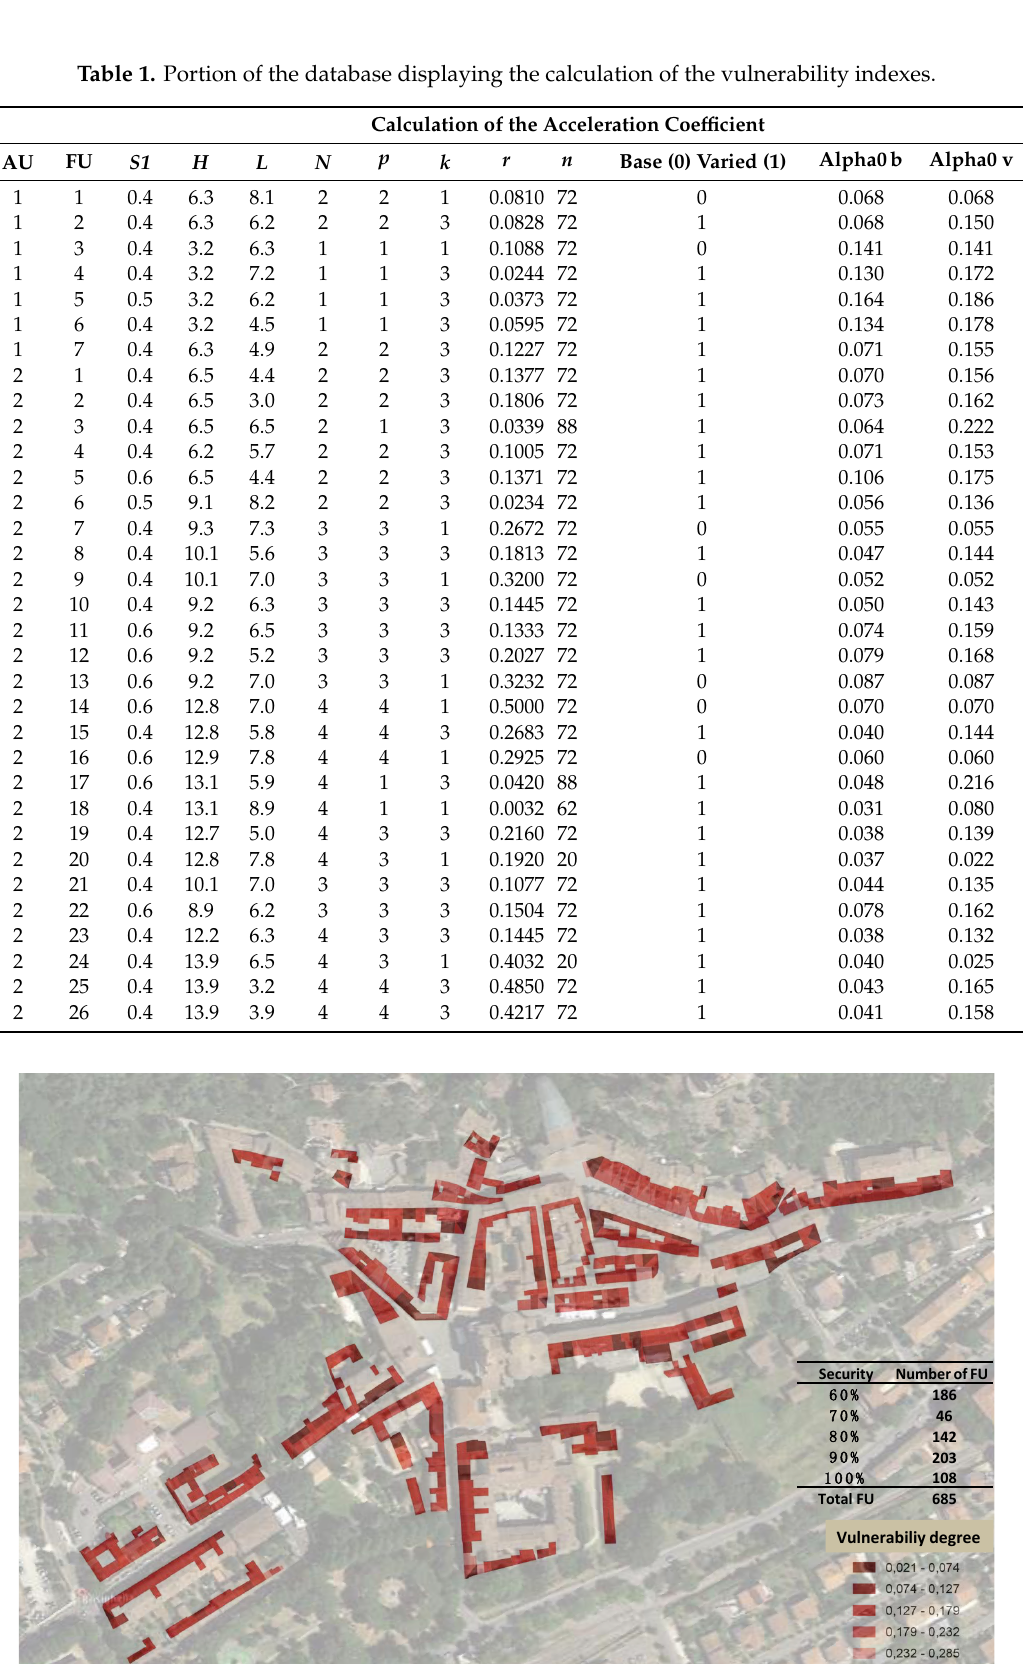
Figure 2. Map of the vulnerability of the Façade Units of the old town of Brisighella. The table classifies the Façade Units by vulnerability degree.